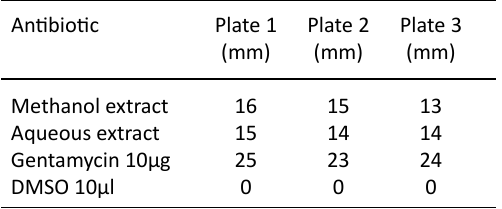
Table 2. Escherichia coli zone of inhibition Antibiotic